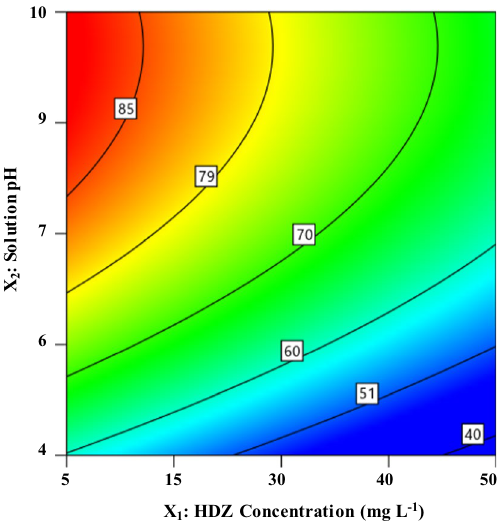
Fig. 4 Contour plot of the solution pH and initial HDZ concentration on the HDZ removal